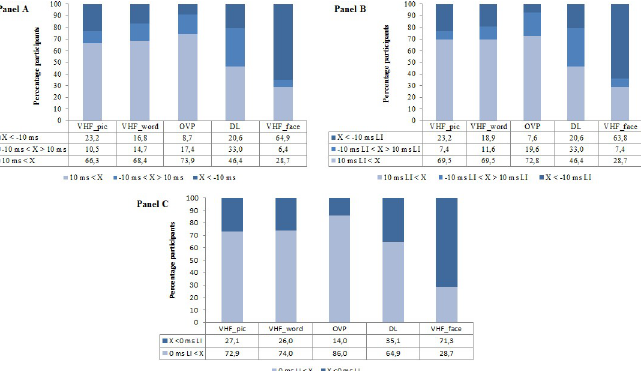
Fig 2. Percentage participants categorized as showing typical, bilateral or atypical lateralization based on their reaction times. Reaction time distributions expressed as percentages and divided in a typical, bilateral and atypical category for the picture visual half field (VHF), word VHF, Optimal Viewing Position (OVP), Dichotic Listening (DL) and face VHF tasks. Panel A classifies the participants based on raw differences between the left and right visual field or ear. The data in Panels B and C are based on lateralization indices (LIs) that represent a mean reaction time difference of 10 ms (same values as in Panel A for the DL task) and 0 ms respectively. Panel B shows the distribution based on LI scores for each task. We further chose to calcu- late an LI limit for the three categories based on the current dataset, i.e. LI scores that represent a mean RT difference of 10 ms between the VHFs in our sample (absolute LI boundary value for Picture VHF: 0.71, Word VHF: 1.13, OVP: 0.97, Face VHF: 1.03). A 10 ms/items boundary